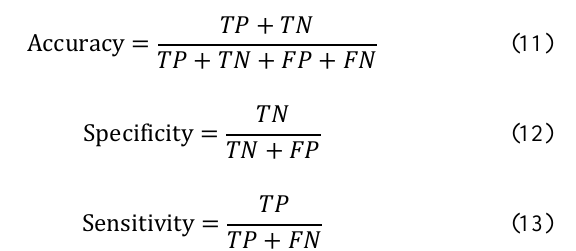
Fig. 3. Image (a) is the ground truth image and (b) is the segmentation result After matching all the pixels of the ground truth and segmentation result, the accuracy, specificity and sensitivity is measured by using (11), (12) and